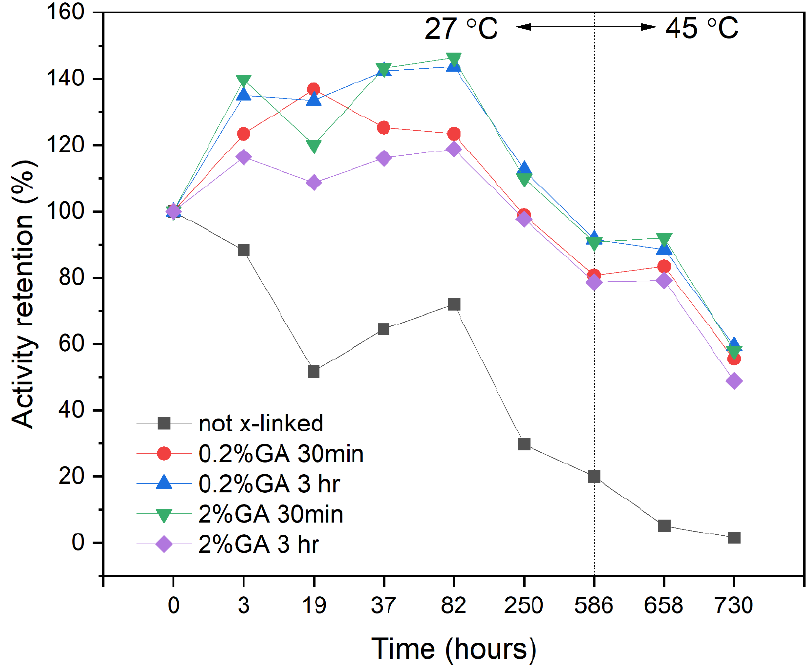
Figure 4. Accelerated longevity test with end-to-end mechanical agitation in 10 wt% K 2 CO 3 (pH 10.5) solvent for post-entrapment crosslinked samples.